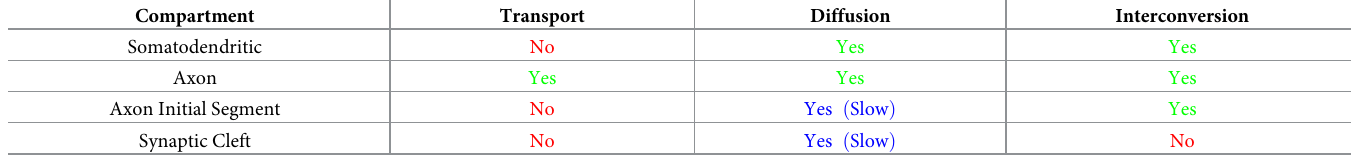
Table 2. Table indicating which processes are modeled in each biological compartment. See Methods: Model Description for more details.